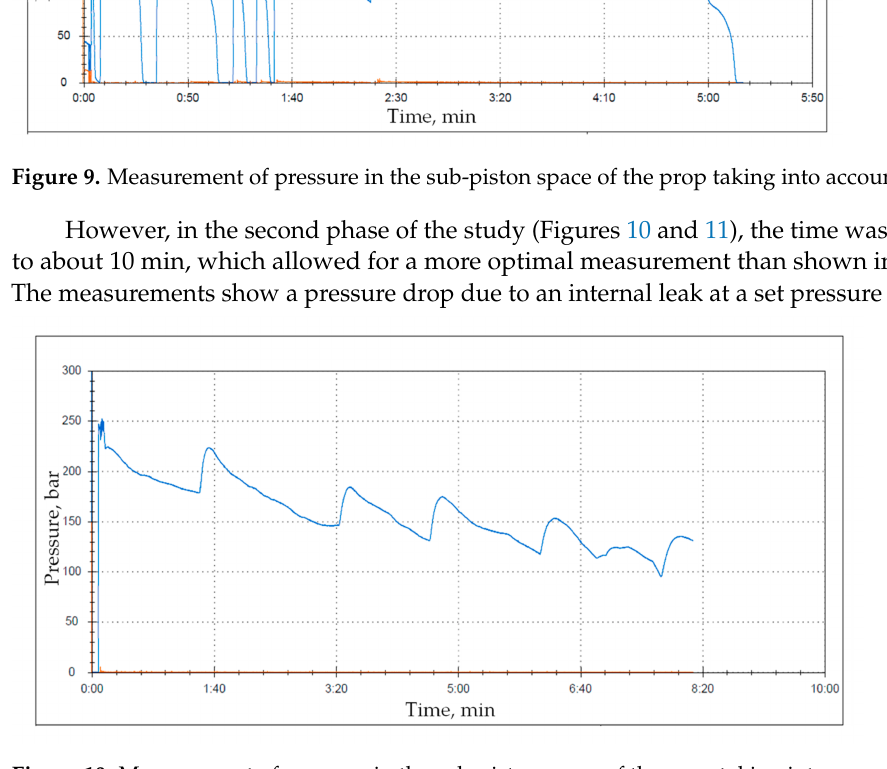
Figure 10. Measurement of pressure in the sub-piston space of the prop taking into account leakage.